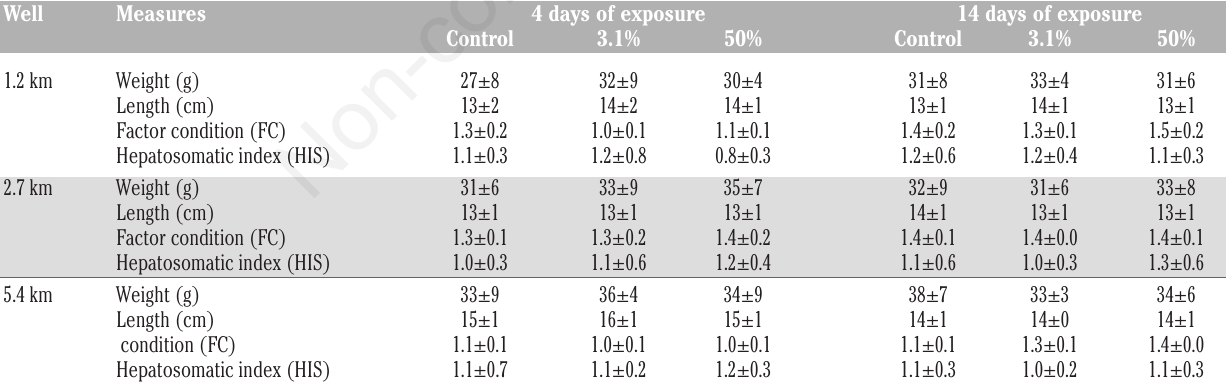
Table 3. Morphometric data of trout exposed to groundwater at 1.2 km, 2.7 km and 5.4 km.